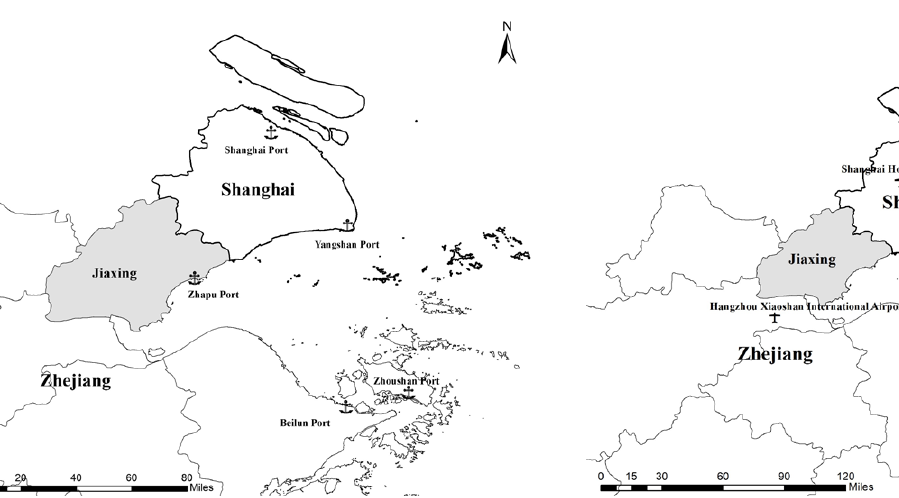
Figure 6. Location of ports in Jiaxing and nearby areas Figure 7. Location of airports in Jiaxing and nearby